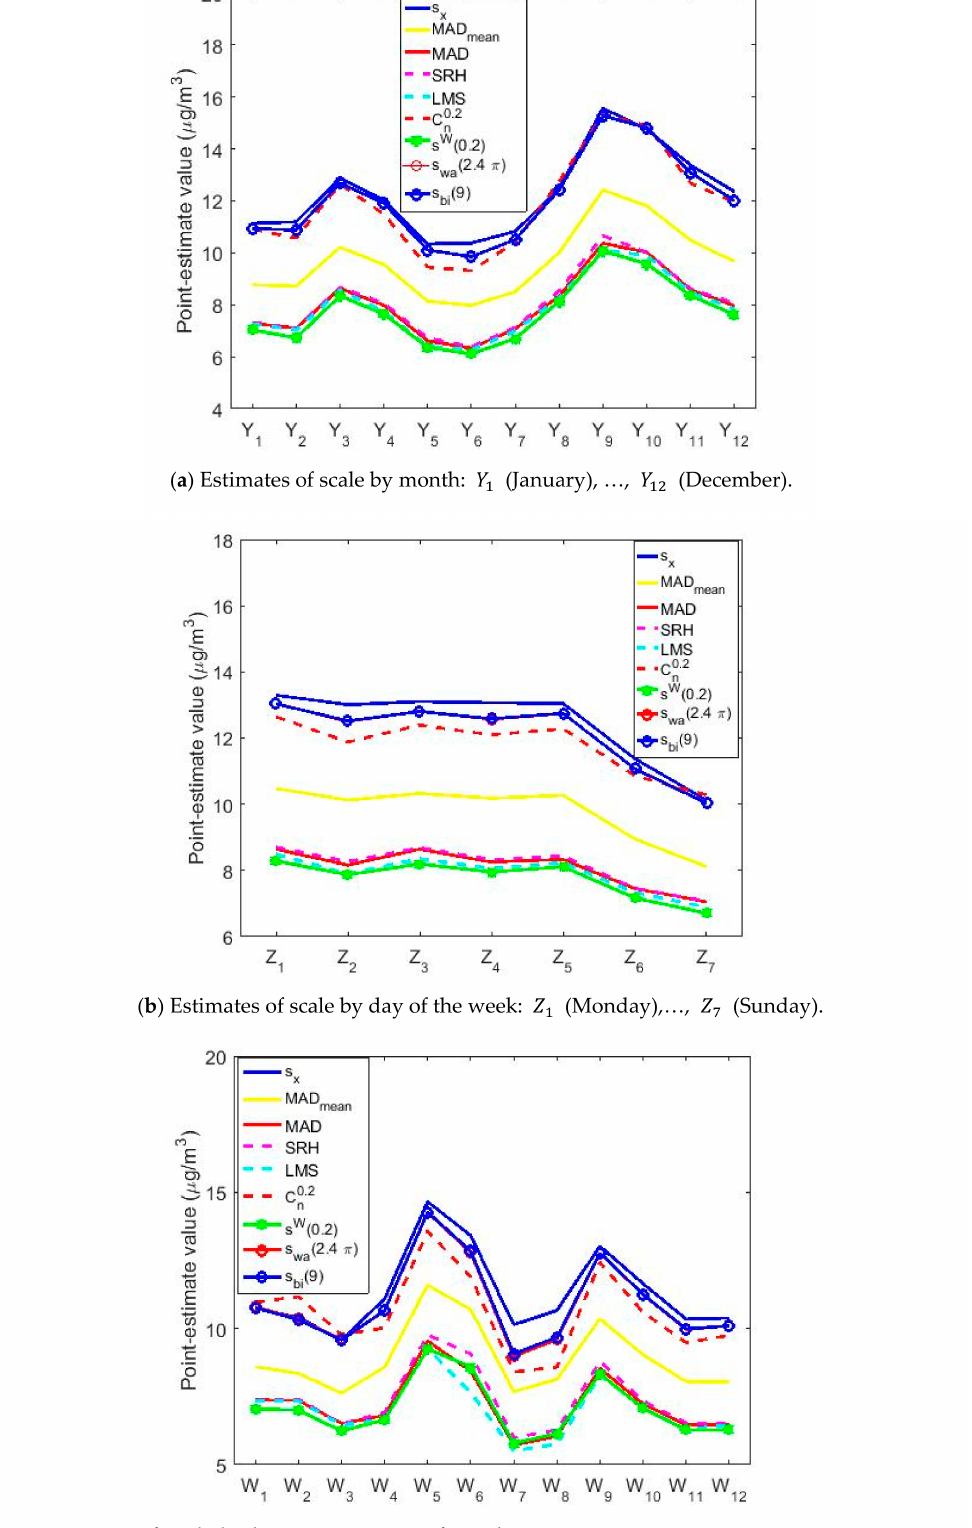
Figure 18. Estimates of scale by month, day and